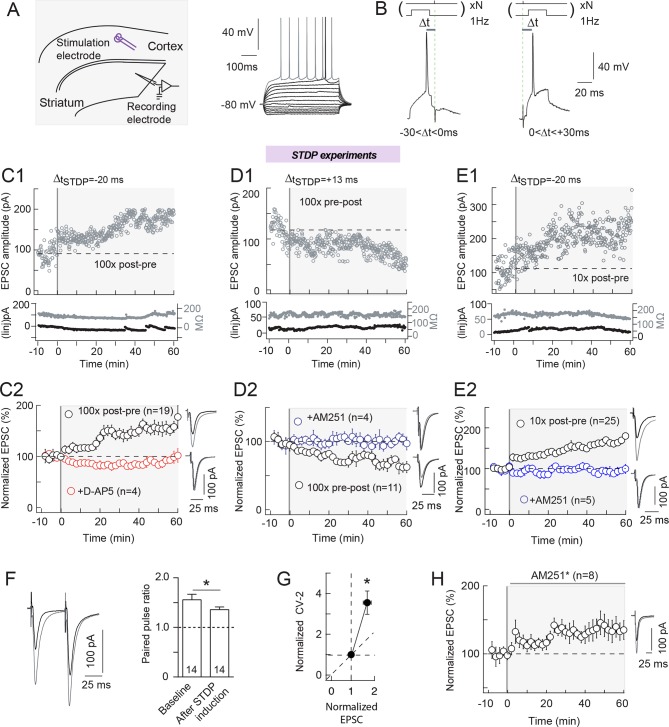
Bidirectional endocannabinoid-mediated STDP depends on the number of
pairings.(A) Whole-cell recording from the dorsal striatum with the
stimulation electrode placed in layer 5 of the somatosensory cortex in
horizontal rat brain slice. (B) Experimental design.
Extracellular stimulation evoked EPSCs monitored at RMP. During pairings,
recordings were switched to current-clamp to allow postsynaptic MSN to
fire single action potentials paired with single cortical extracellular
stimulations. MSN and cortical stimulation were repeated N times (10 or
100) at 1 Hz. ΔtSTDP indicates the time delay between pre- and
post-synaptic stimulations. -30<ΔtSTDP<0 ms and
0<ΔtSTDP<+30 ms refers to post-pre and pre-post
pairings, respectively. (C) 100 post-pre pairings induced
NMDAR-mediated tLTP. (C1) Example of tLTP induced by 100
post-pre pairings. Top, EPSC strength before and after pairings (before
pairings: 91±3 pA; 45–55 min after pairings: 169±2 pA; increase of 87%).
Bottom, time courses of Ri (before, 132±1 MΩ; after, 134±2 MΩ; change of
2%) and injected current (Iinj) (before, -2±1 pA; after, -12±2 pA; change
of 6% of baseline EPSC amplitude) for this cell. (C2)
Summary of tLTP induced by 100 post-pre pairings. 15/19 cells showed
significant tLTP. Inhibition of NMDAR with D-AP5 (50 μM, n=4) prevented
the induction of tLTP; 4/4 cells showed no significant plasticity. The
normality of D-AP5 data was assumed (test not passed). (D)
100 pre-post pairings induced CB1R-mediated tLTD. (D1)
Example of tLTD induced by 100 pre-post pairings. Top, EPSC strength
before and after pairings (before pairings: 134±2 pA; 45–55 min after
pairings: 82±2 pA; decrease of 39%). Bottom, time courses of Ri (before,
156±2 MΩ; after, 157±1 MΩ; change of 1%) and injected current (Iinj)
(before, 14±1 pA; after, 20±1 pA; change of 5%) for this cell.
(D2) Summary of tLTD induced by 100 post-pre pairings.
7/11 cells showed significant tLTD. Inhibition of CB1R with AM251 (3 μM,
n=4) prevented the induction of tLTD; 4/4 cells showed no significant
plasticity. The normality of AM251data was assumed (test not passed).
(E) 10 post-pre pairings induced CB1R-mediated tLTP.
(E1) Example of tLTP induced by 10 post-pre pairings.
Top, EPSC strength before and after pairings (before pairings: 112±4 pA;
45–55 min after pairings: 213±4 pA; increase of 90%). Bottom, time
courses of Ri (before, 171±2 MΩ; after, 167±1 MΩ; change of 2%) and
injected current (Iinj) (before, 10±1 pA; after, 12±1 pA; change of 2%)
for this cell. (E2) Summary of tLTP induced by 10 post-pre
pairings. 21/25 cells showed significant tLTP. Inhibition of CB1R with
AM251 (3 μM, n=5) prevented the induction of tLTP; 5/5 cells showed no
significant plasticity. Normality was assumed for the ctrl 10x post-pre
data (test not passed). (F-H) eCB-LTP is maintained by a
mechanism located downstream of CB1R activation in the presynaptic
terminals. (F) Representative EPSCs and summary bar graphs
(n=14) of paired-pulse cortical stimulations (50 ms interstimulus
interval) illustrate a decrease of facilitation after 10 post-pre
pairings. This indicates a presynaptic locus of the eCB-tLTP.
(G) Mean variance analysis (CV-2, n=17)
indicates a presynaptic locus of the eCB-tLTP maintenance.
(H) Summary of tLTP induced by 10 post-pre pairings with
application of CB1R inhibitor just after the pairings (AM251*) (7/8 cells
showed significant tLTP). This treatment did not prevent tLTP, indicating
that the maintenance of eCB-tLTP does rely on the signaling downstream of
CB1R. Normality was assumed for the data og CV-2 after STDP
protocol (test not passed). Representative traces are the average of 15
EPSCs during baseline (black traces) and 50 min after STDP protocol (grey
traces). Error bars represent s.d. *p<0.05. ns: not significant.